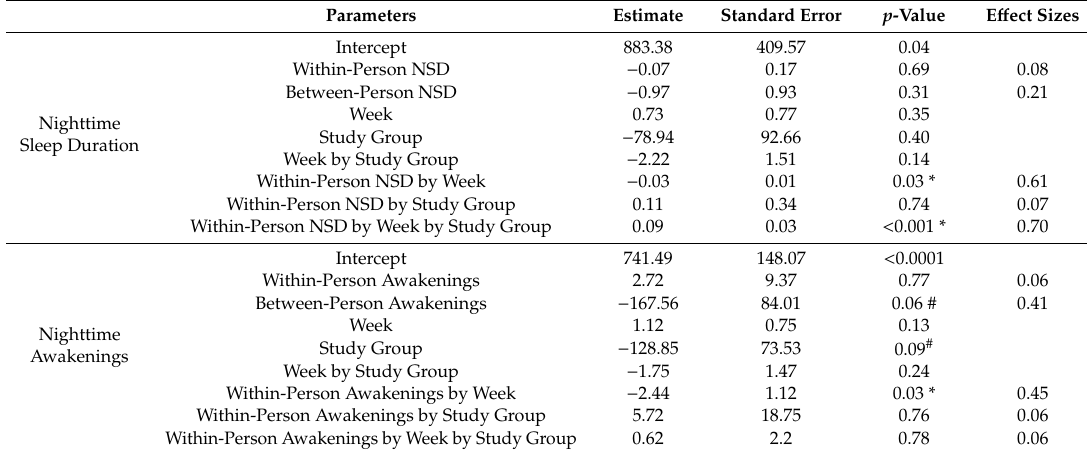
Table 4. Coe ffi cients for the Multilevel Models of Nighttime Sleep Duration and Nighttime Awakenings Predicting Weekly Physical